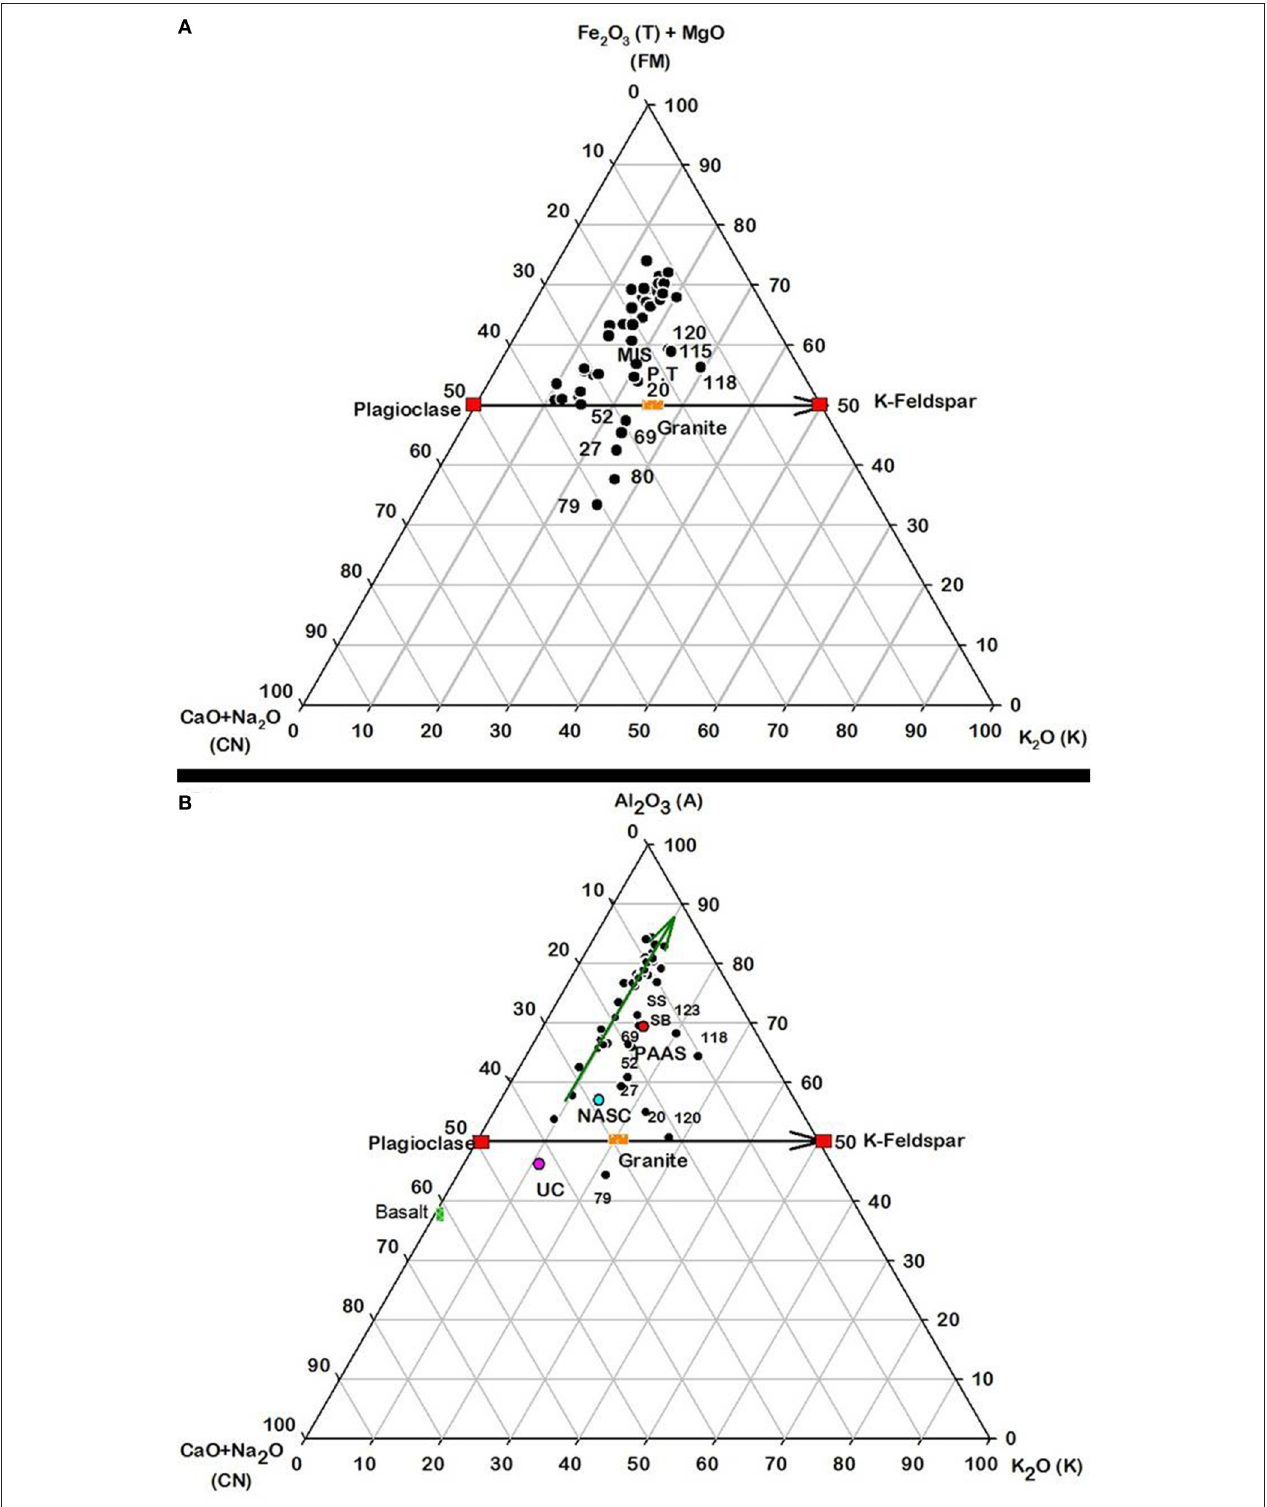
FIGURE 4 | (A) FM-CN-K and (B) A-CN-K ternary plots of Andaman Shelf sediments. Numbers within the ternary plots indicate the sample numbers. Values for the basalts, granites, Upper crust (UC), Post-Archean Australian Shale (PAAS) and Noth American Shale Composite (NASC) are also plotted (Taylor and McLennan, 1985). The FM-CN-K plot suggests mafic lithology as the dominant source of the majority of the sediments which have undergone through variable chemical weathering evolving toward Al 2 O 3 apex (A-CN-K